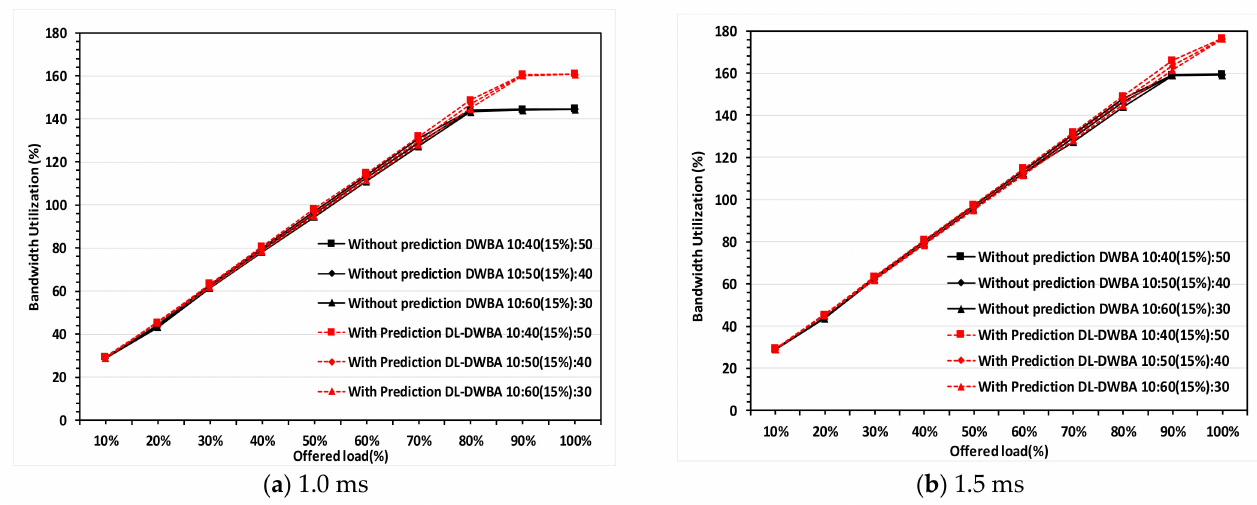
Figure 8. Overall system